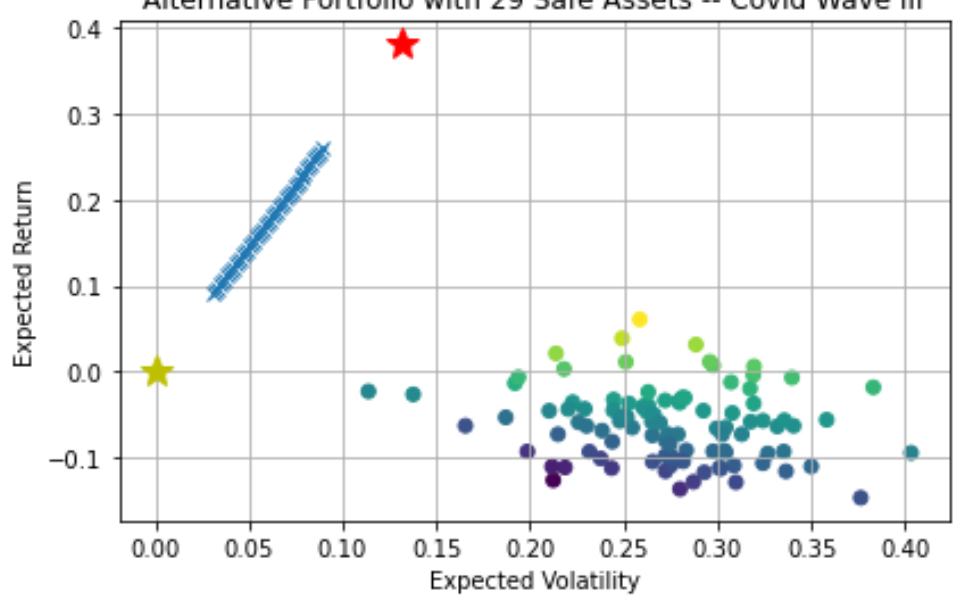
Figure 28. COVID-19 Wave III—Portfolio Optimization: Expected Risk and